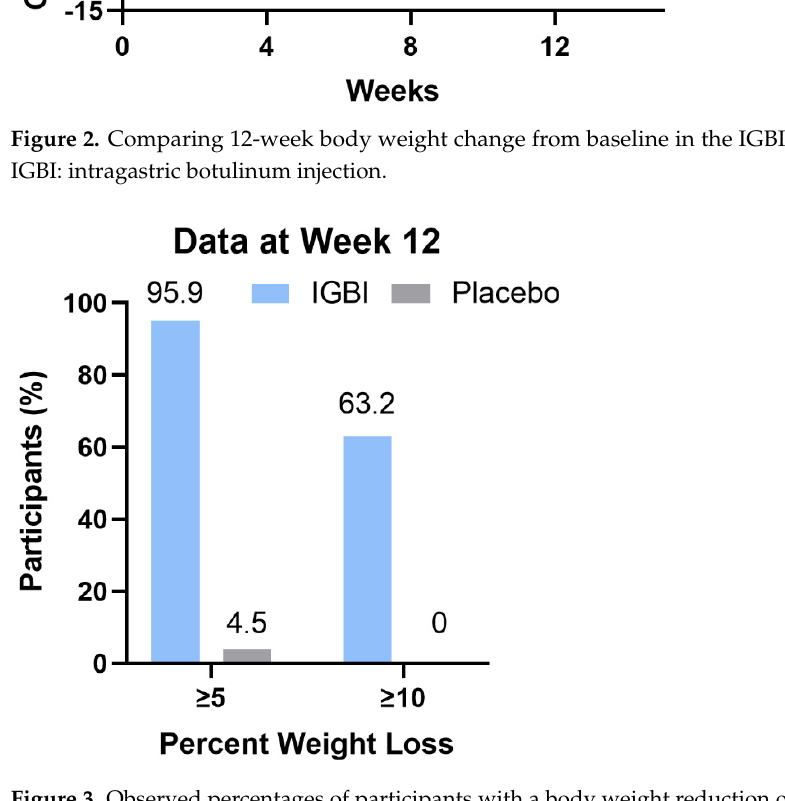
Figure 3. Observed percentages of participants with a body weight reduction of at least 5% and 10% from baseline to week 12 during the study period in the IGBI and placebo groups. IGBI: intragastric botulinum